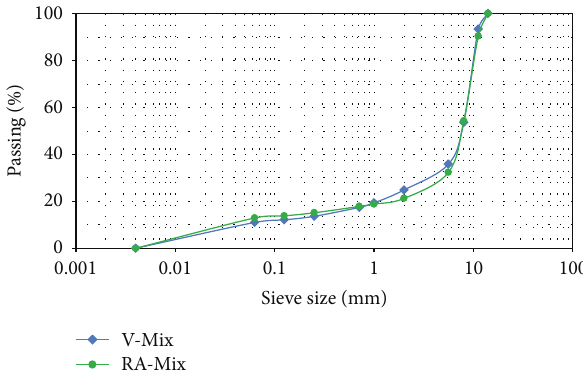
Figure 1: Aggregate grading curves of V-Mix and